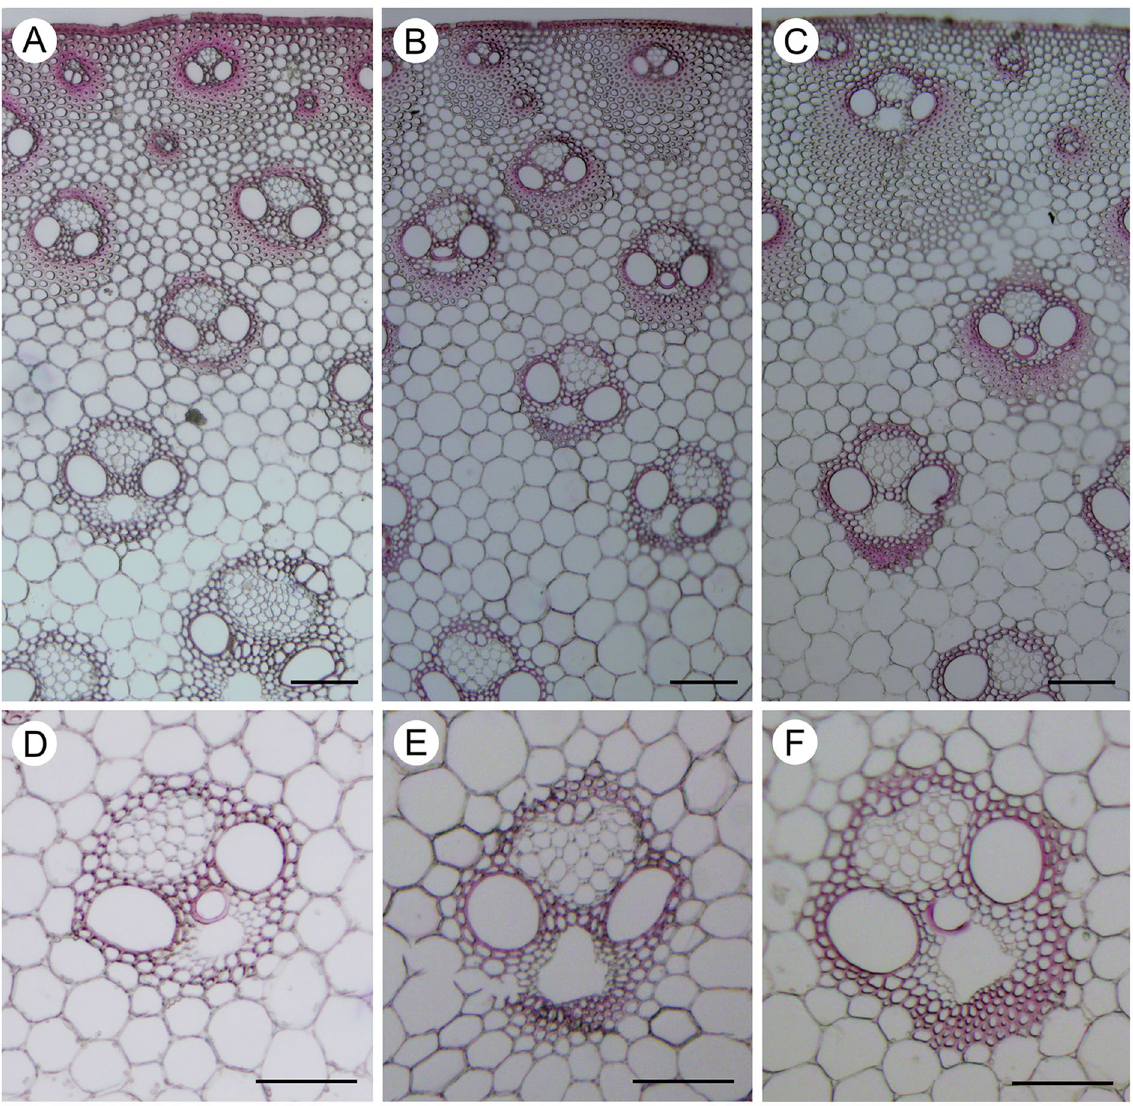
Figure 2. Lignification in an elongating internode of M. lutariorioparius . Lignification in three segments of an elongating internode (2 nd from top) was shown by Phloroglucinol-HCl staining (red color). ( A ) upper internode (UI), ( B ) middle internode (MI), ( C ) basal internode (BI), ( D , E and F ) are enlarged view of a specified vascular bundle in ( A , B and C ) respectively. Bar = 100 μ